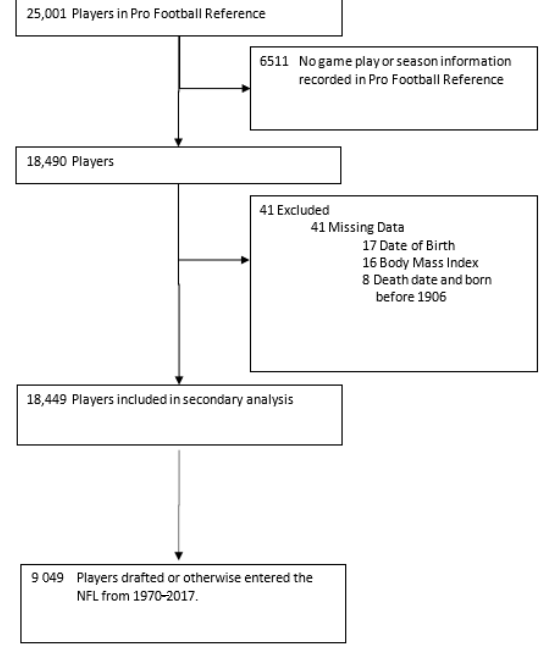
Figure 1. Cohort flow chart.